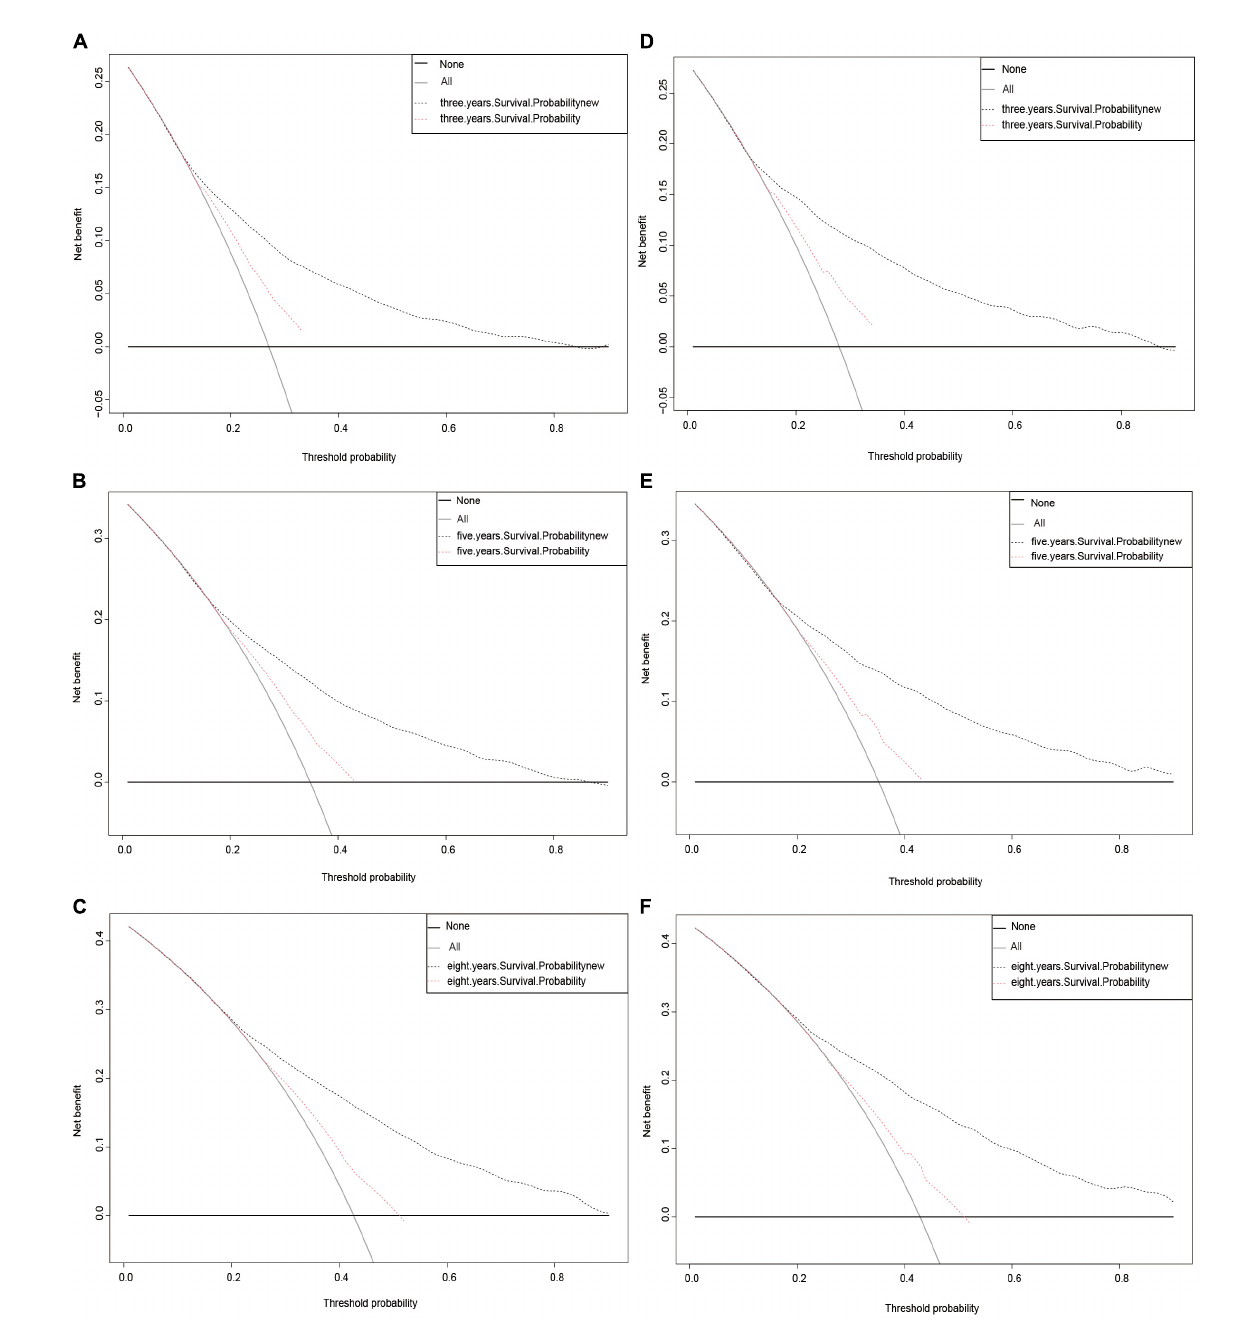
FIGURE5 Decision curve analysis curves. Decision curve analysis of the training cohort (A–C) and validation cohort (D–F) for 3-, 5-, and 8-years CSS